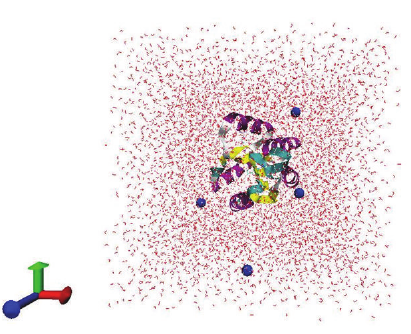
Figure 2: Neutralization of system by addition of four sodium ions. Stick model represents the water molecules and ball model represents NA ions (Blue) and protein is shown as ribbon enclosed inside the box with secondary structure